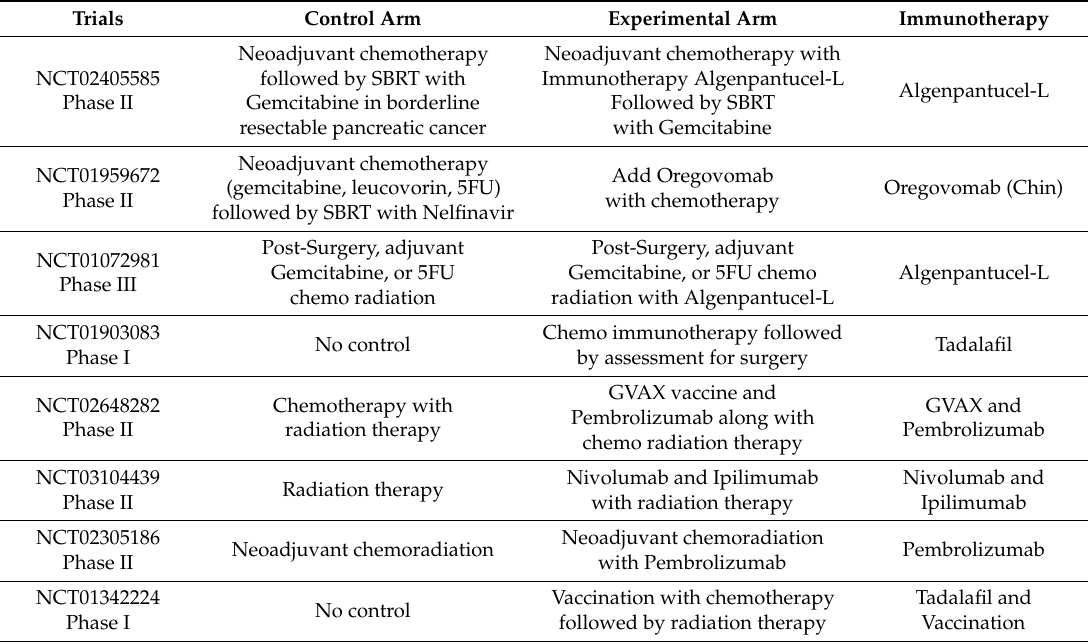
Table 2. Pancreatic Cancer Clinical Trials with Immunotherapy combined with RT and Chemotherapy.